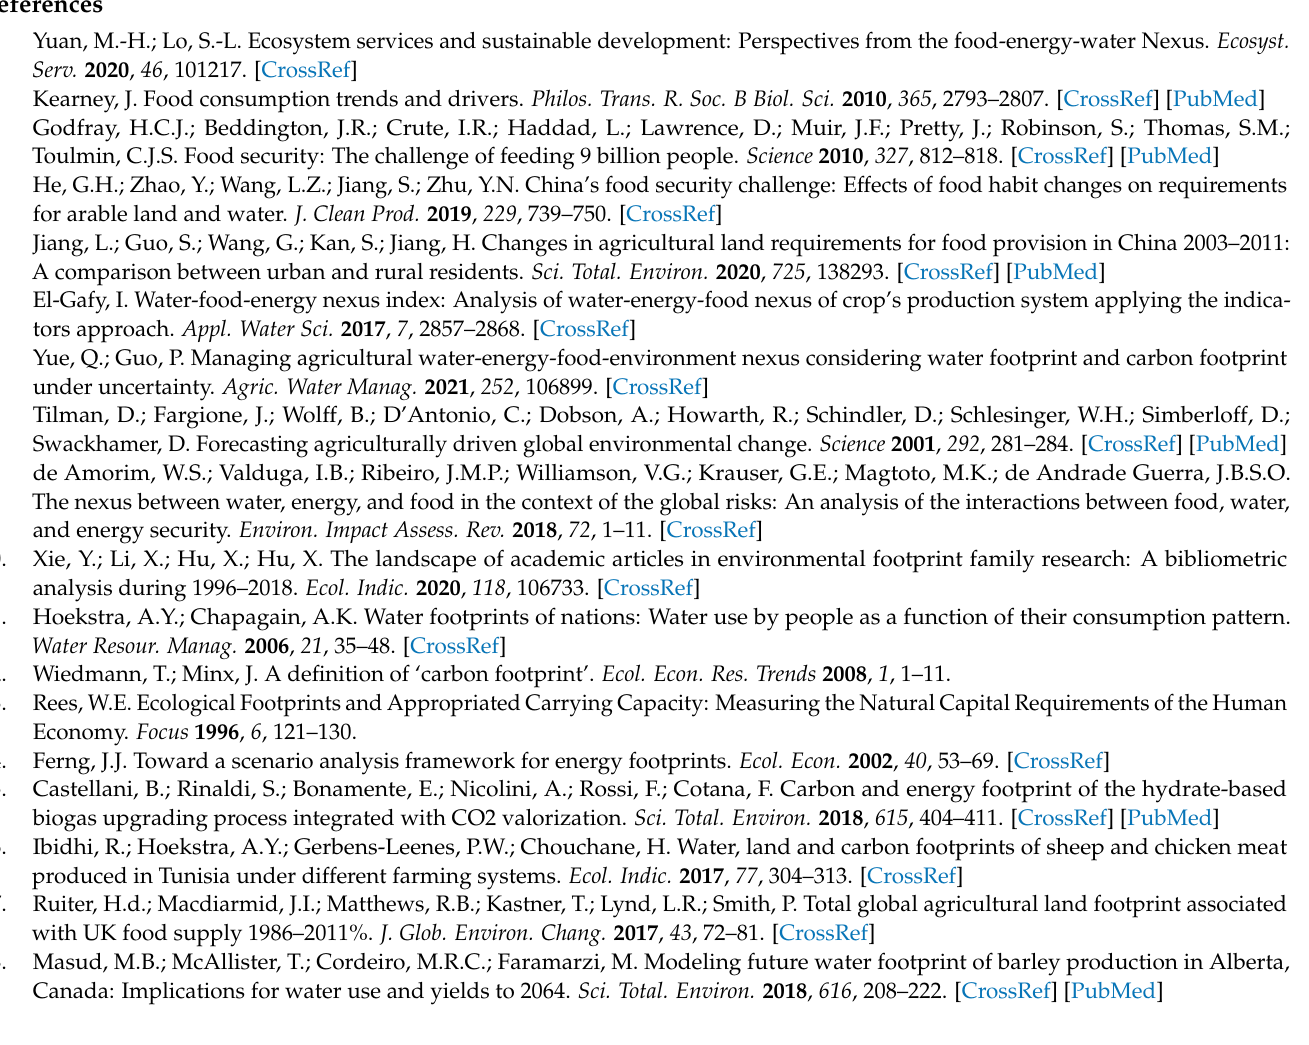
NF, Figure S5: Spa-tial-temporal analysis for EF, Figure S6: Spatial-temporal analysis for